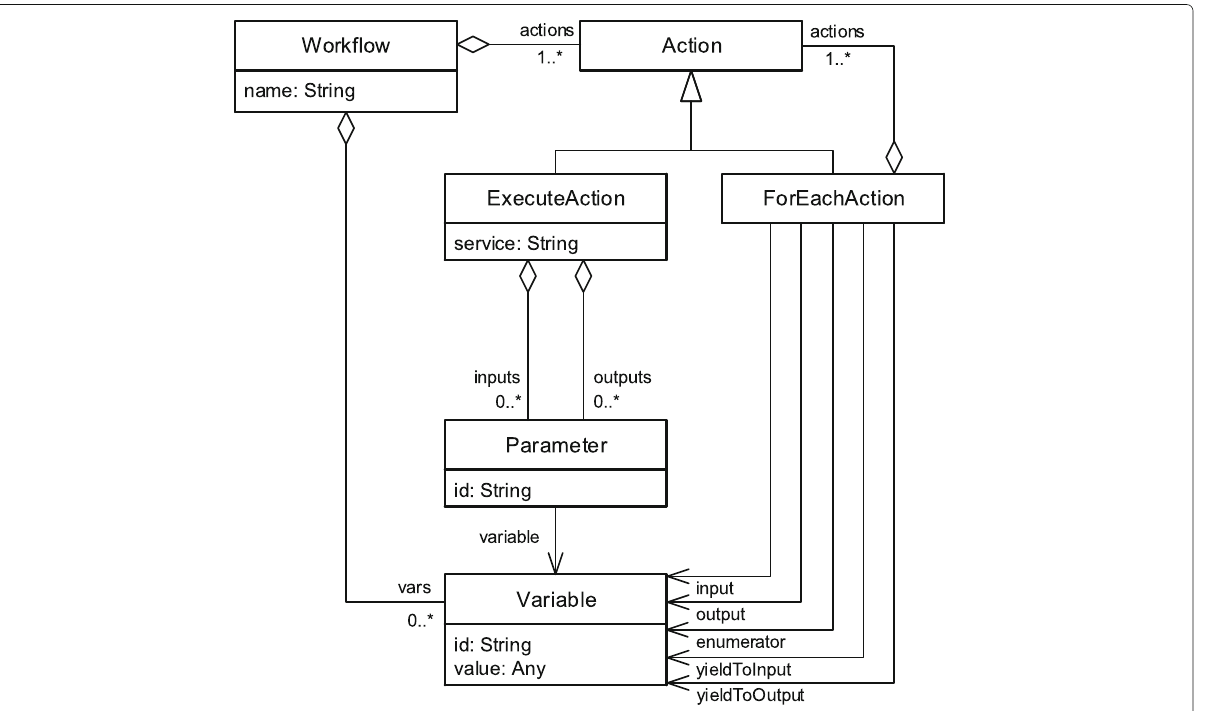
Fig. 2 UML class diagram of the workflow